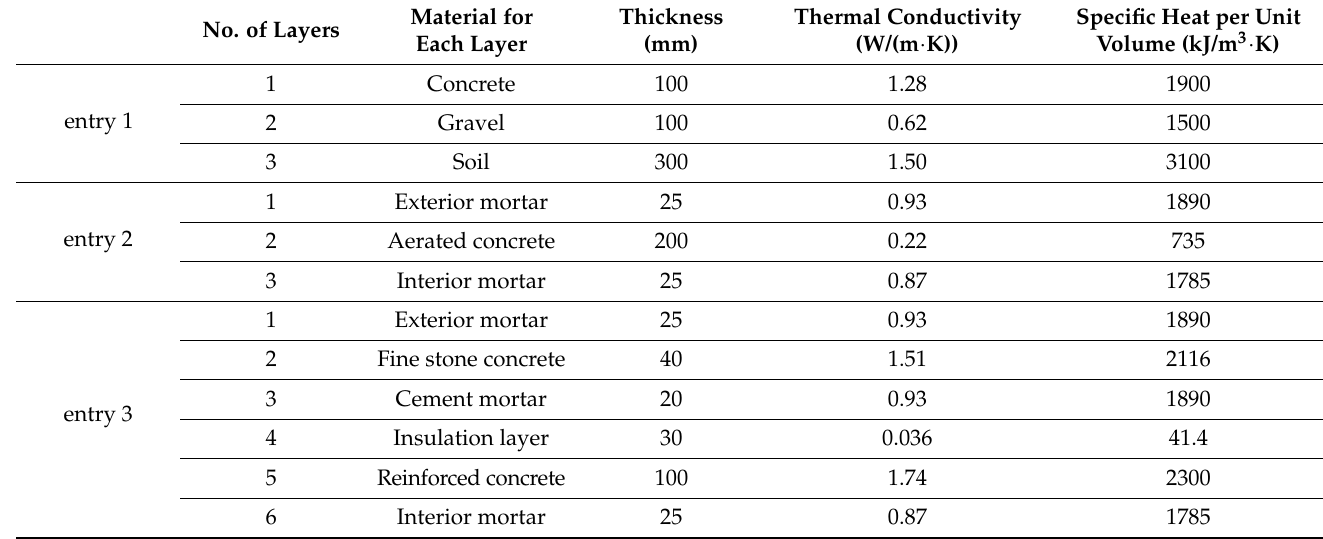
Table 1. Structures and thermal properties of the ground, wall, and